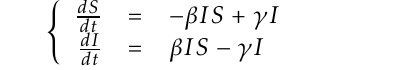
Coupling and comparing agent-based and equa tion-